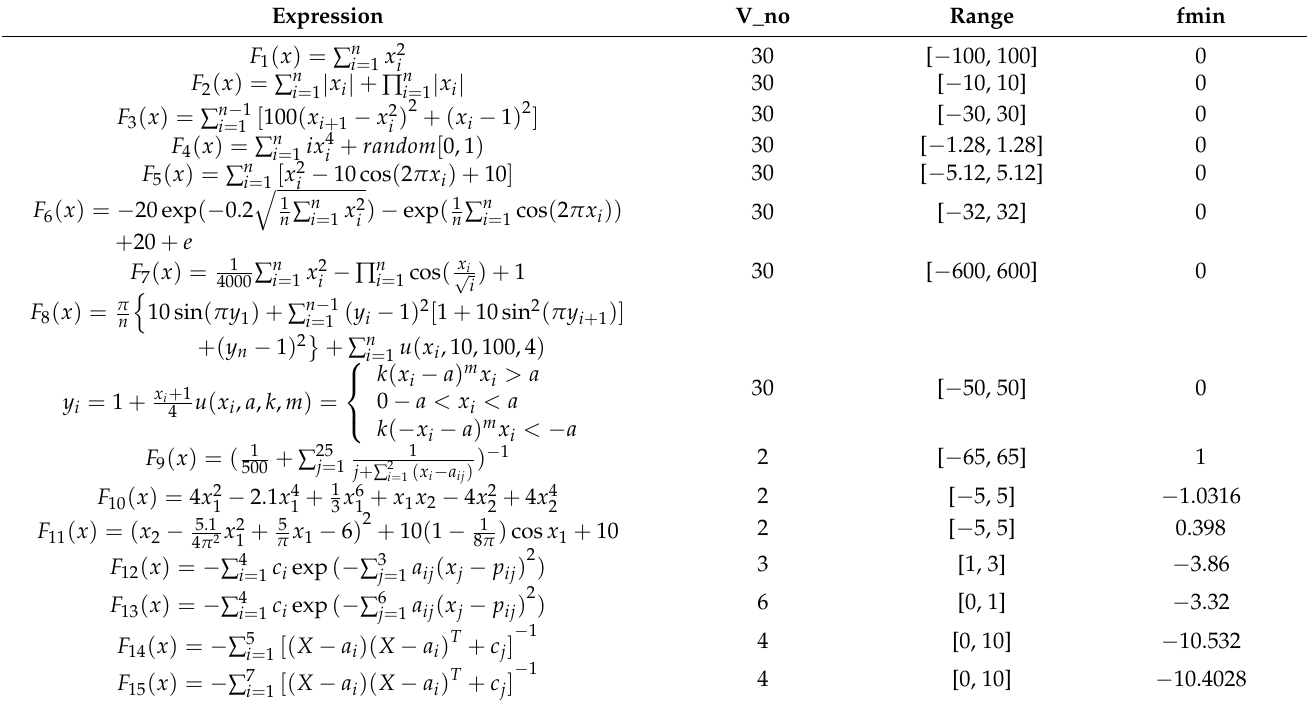
Table 3. Details of 15 benchmark